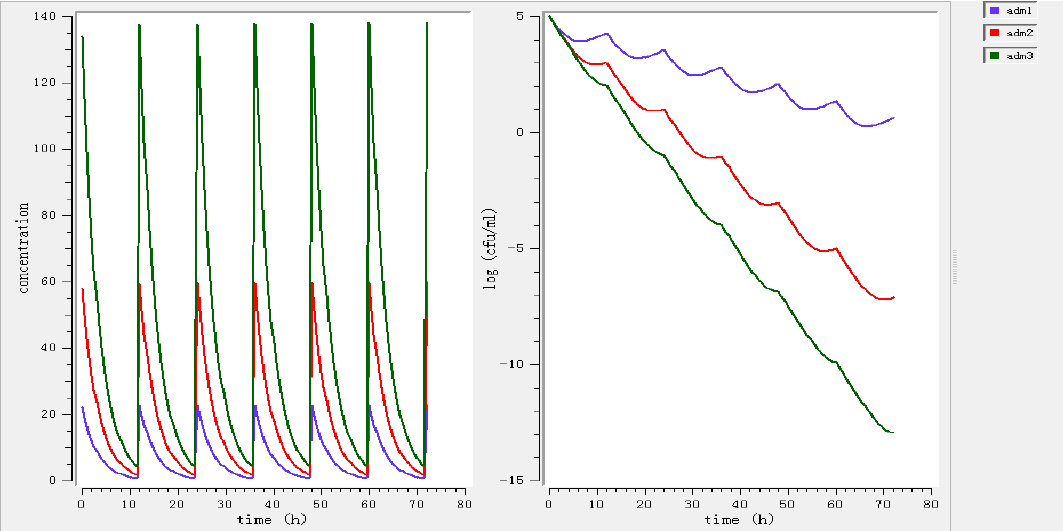
Figure 5. Model predictions of drug concentration ( left ) and bacterial growth ( right ) at different dose regimens with 12 h intervals by Mlxplore (adm1: Preventive dose, adm2: Therapeutic dose, adm3: Eradication dose).